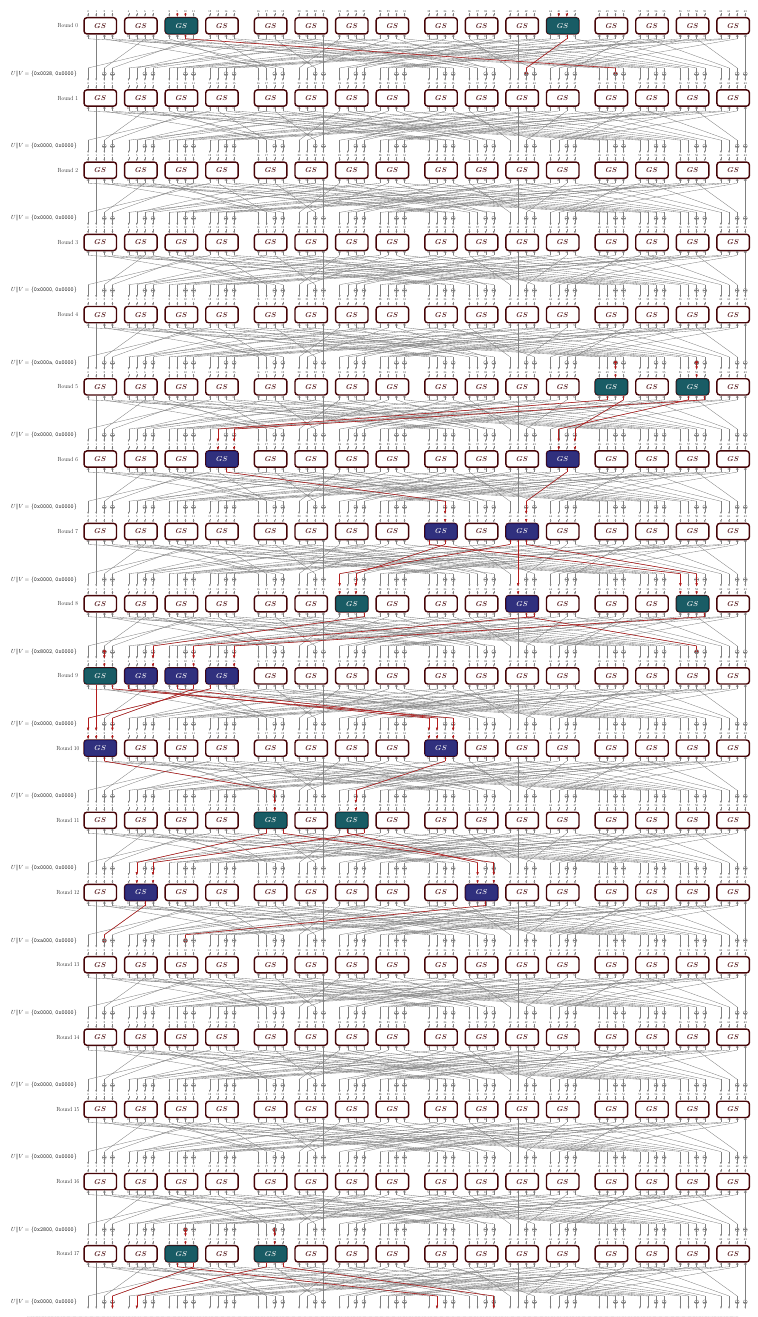
Figure 8: 18-round related-key differential trail of GIFT-64 with probability 2 − 58